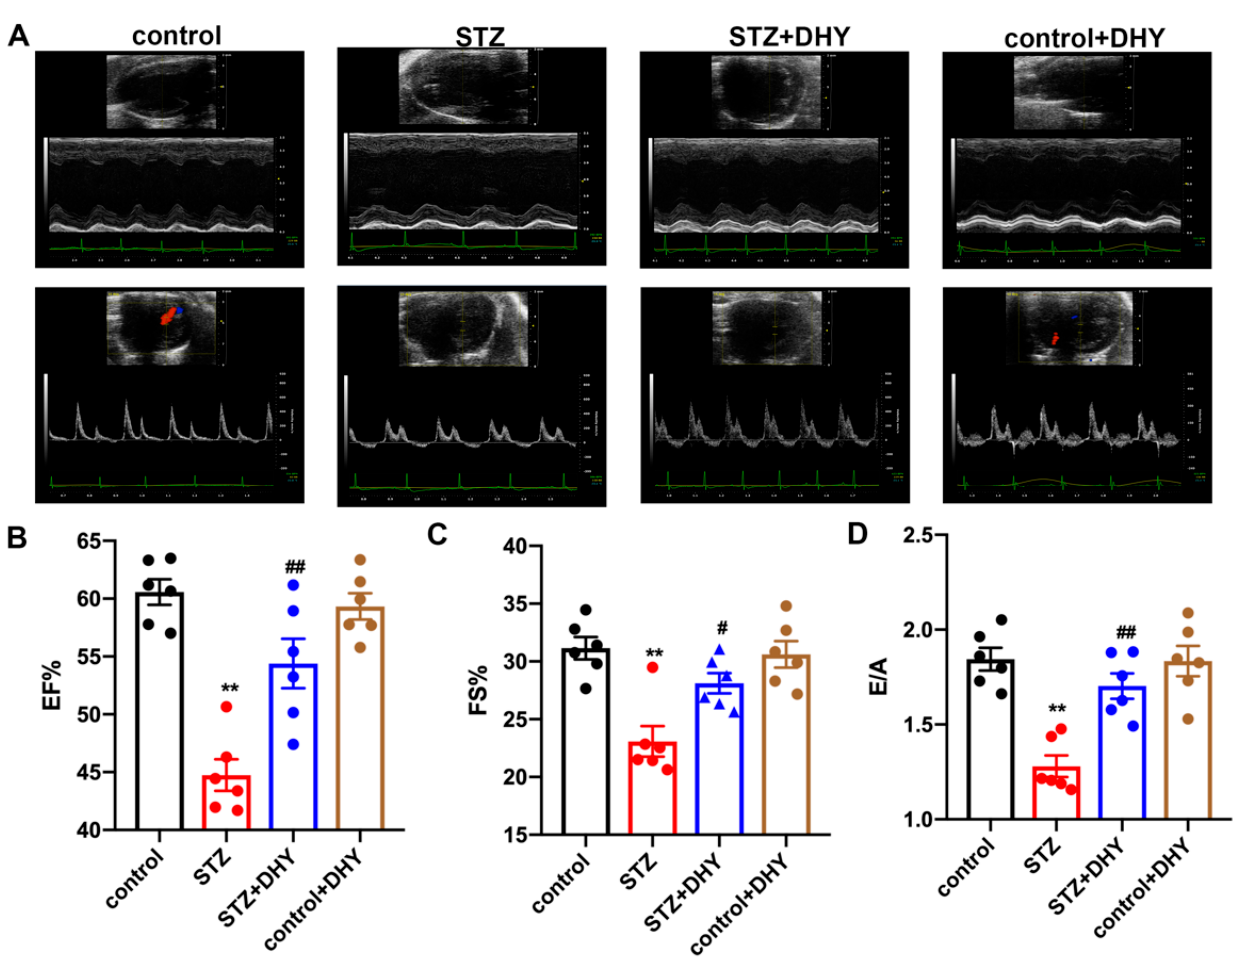
Figure 2. DHY improved cardiac dysfunction in STZ-induced C57BL/6 mice. ( A ) Representative echocardiographs of two-dimensional M-mode and doppler of mice. ( B ) EF. ( C ) FS. ( D ) E/A ratio. ** p < 0.01 versus control; # p < 0.05, ## p < 0.01 versus STZ, n = 6.